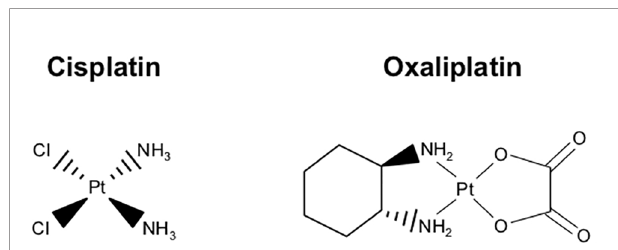
FIGURE 9 | Chemical structure of Oxaliplatin and structural similarity to Cisplatin. Oxaliplatin is structurally similar to Cisplatin, though it differs in the replacement of amine groups with diaminocyclohexane and the chlorine ligands with oxalate, thereby increasing antitumor activity and water